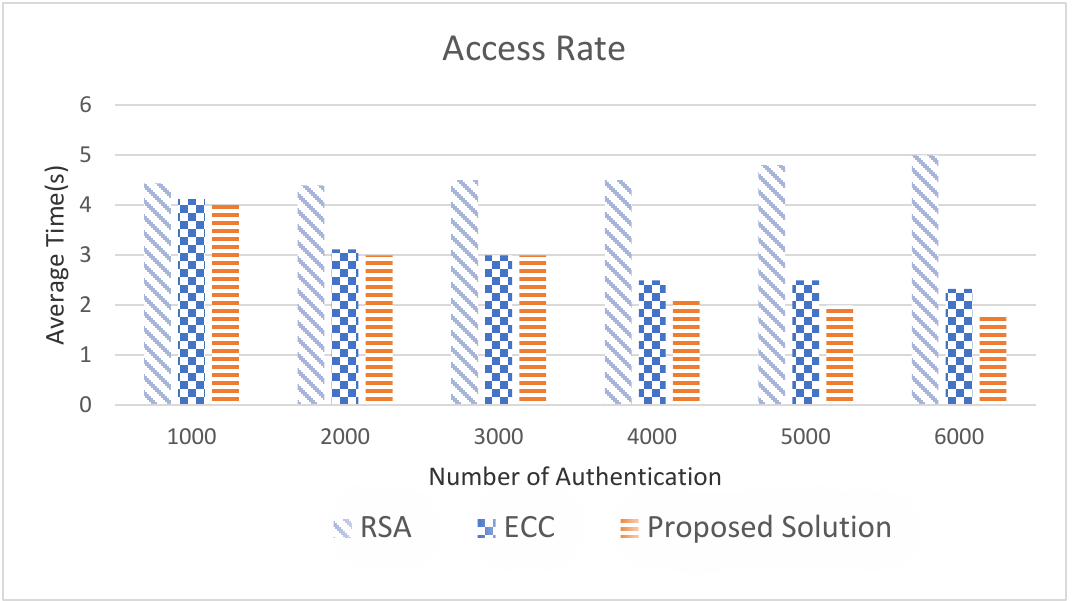
Figure 14. Access rate of authentication of UAVs with user’s host.